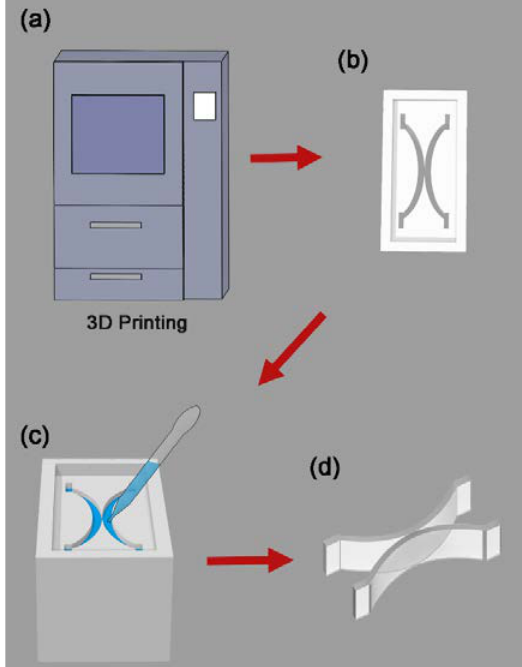
Figure 2. Schematic for X-shaped actuator fabrication: ( a ) the designed mold was fabricated with a 3D printer, ( b ) the mold was printed, ( c ) the silicone mixture was poured into the mold and solidified, and ( d ) the X-shaped silicone fabrication was completed.